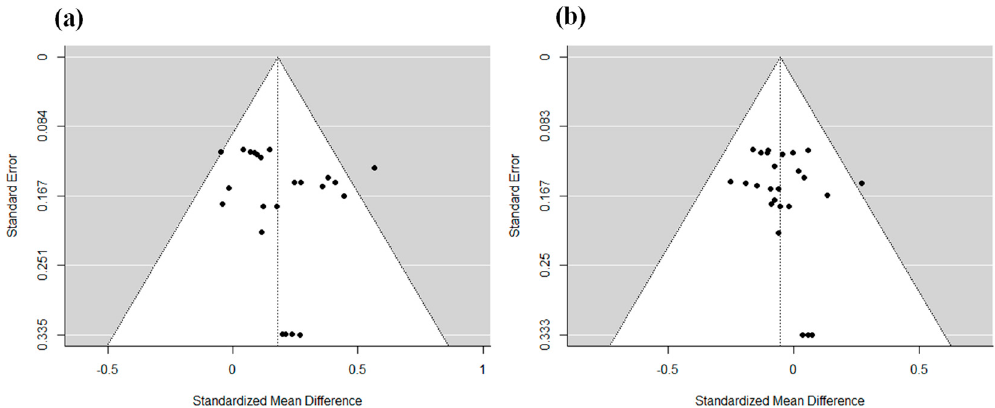
Figure 5. Funnel plot for publication bias: ( a ) speed of answer and ( b ) the error of rate. Each study in the analyses is plotted as a black dot. The vertical lines are the results of the meta-analyses.